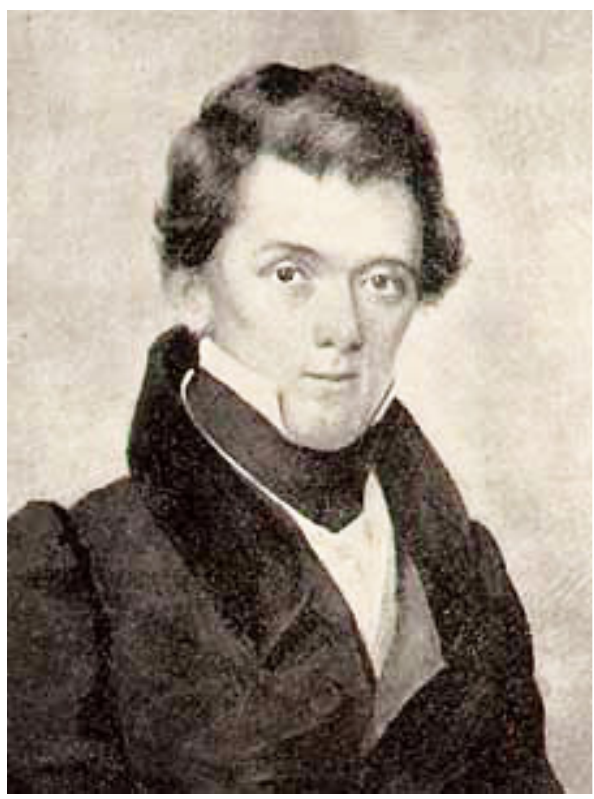
Figure 3. Portrait of Edwin James (Evans, 1950).